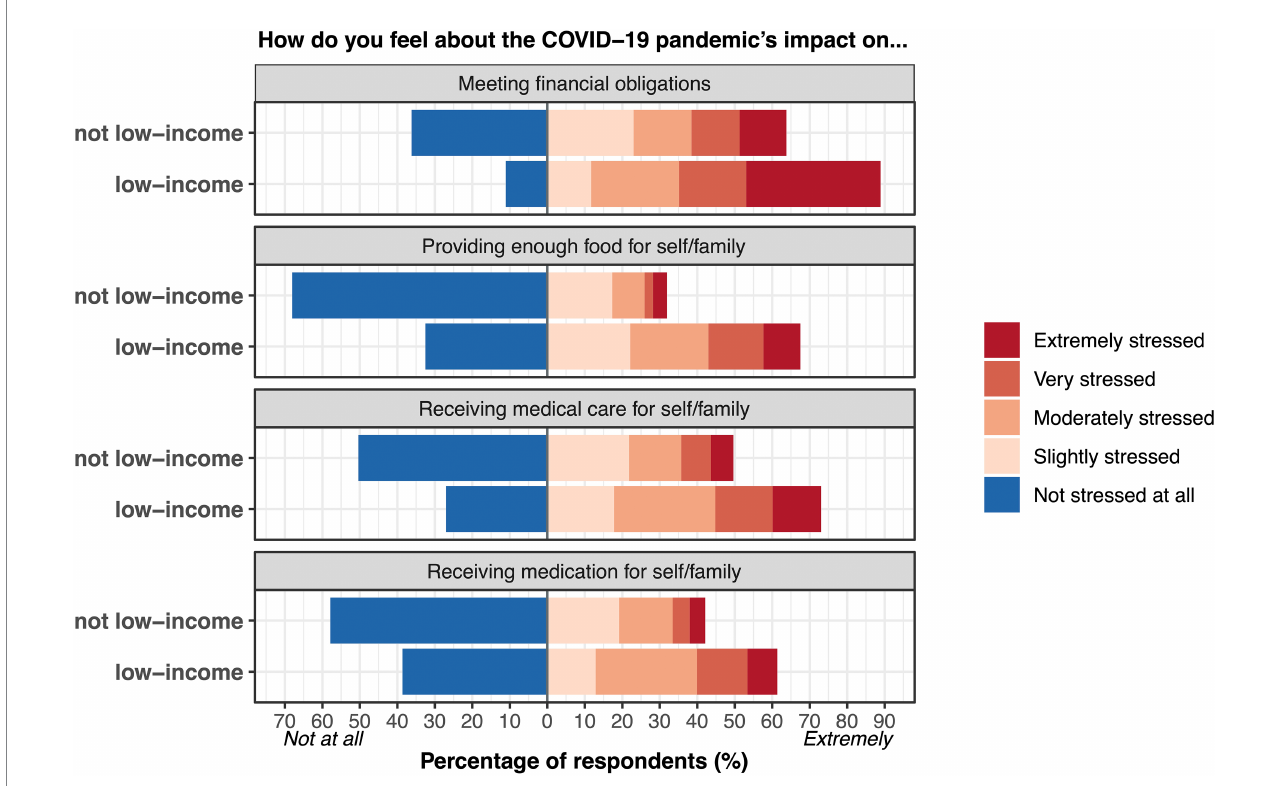
FIGURE 4 Low-income students were disproportionately affected by the pandemic’s impact on daily life stressors. Percentage of responses based on a five-point Likert scale of level of stress to the pandemic’s impact on four daily stressors: meeting financial obligations; providing enough food for self/family; receiving medical care for self/family; and receiving medication for self/family. Low-income is defined as annual household income <$50,000, which was self- reported and included as a survey